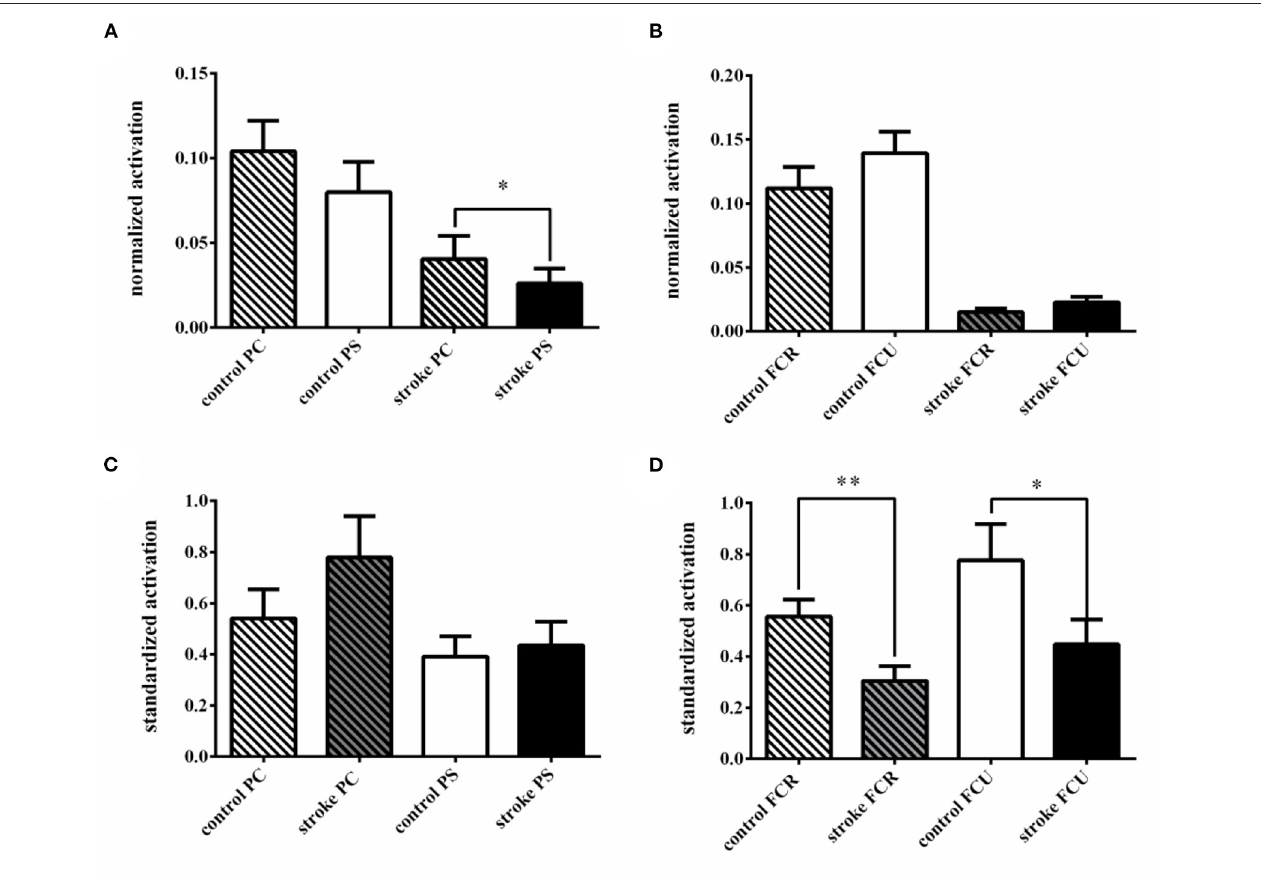
FIGURE 3 | The activation difference between different spinal cord segments in elbow flexion. (A) Comparison of activation difference between the clavicle part of the pectoralis major (PC) and the pectoralis costal part of pectoralis major (PS) in groups; (B) the comparison of activation difference between the Flexor Carpi Radialis (FCR) and the Flexor Carpi Ulnaris (FCU) in groups; (C) comparison of the standardized activation between groups in PC and PS. (D) comparison of the standardized activation between groups in FCR and FCU. * p < 0.05; ** p <